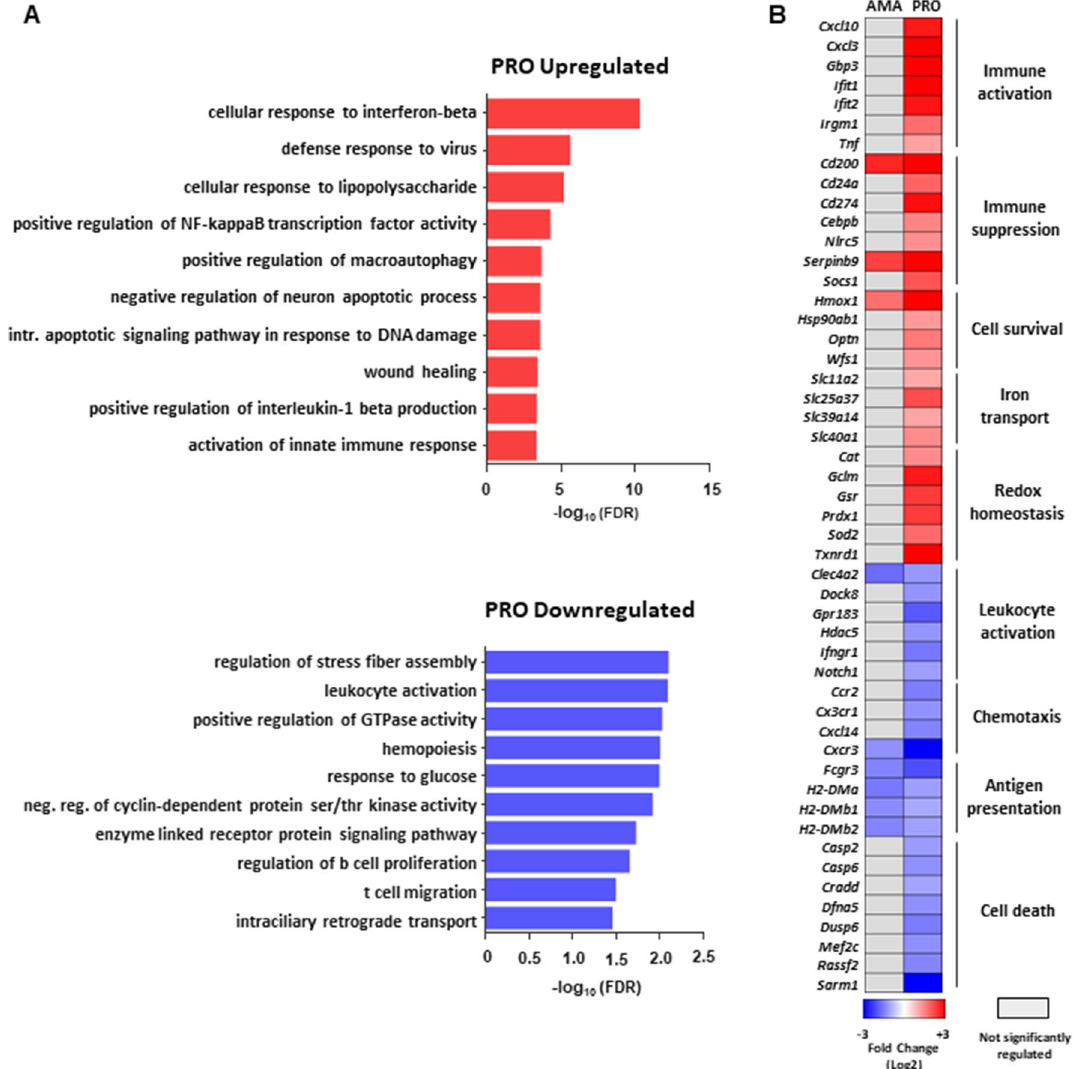
Figure 3. Selective changes in mRNA abundance predict promastigote-specific activation and inhibition of macrophages defense responses during L. donovani infection. ( A ) FDR values (− log 10 ) for selected GO term enriched categories of differentially up- or downregulated mRNAs upon L. donovani PRO infection. ( B ) Changes in mRNA abundance for selected genes in enriched GO terms. Analyses were carried out on data generated from at least three biological